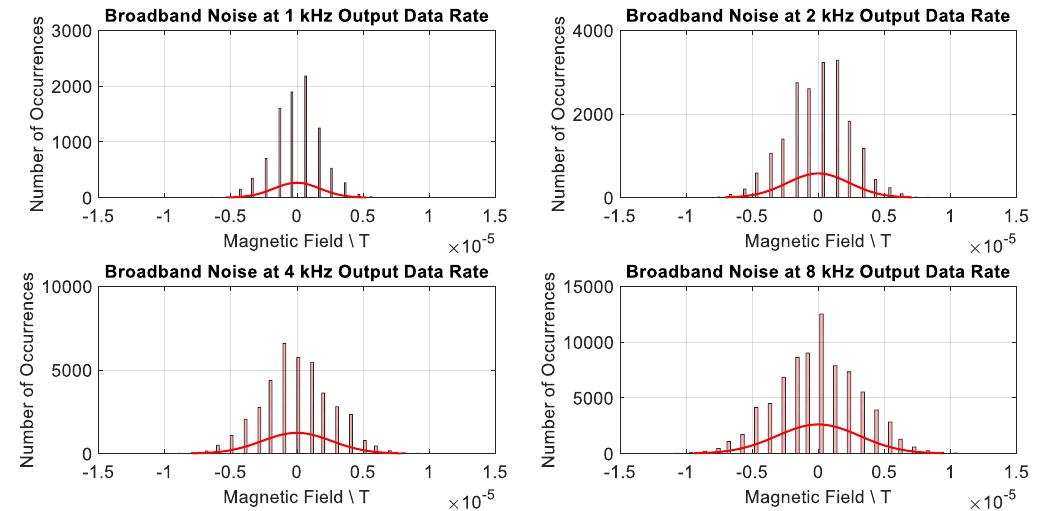
Figure 9. Broadband noise performance plots for the different output data rate settings. One can note that the DC component is filtered out by the external digital band pass filter.